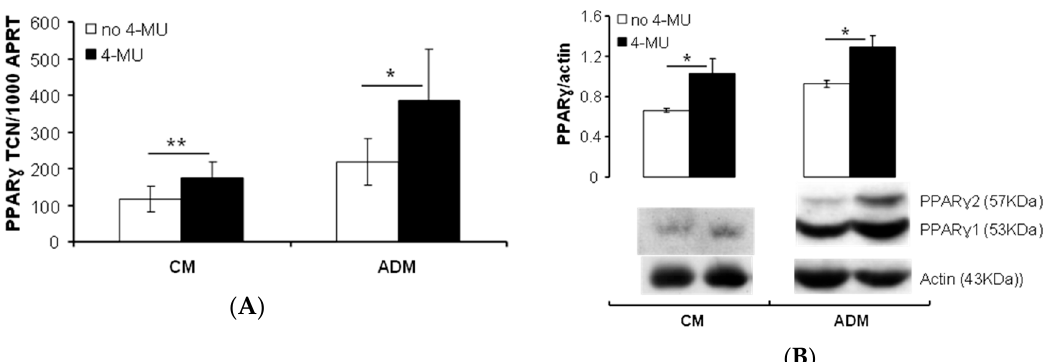
Figure 3. Enhanced PPAR γ expression by 4-MU treatment. Confluent primary subcutaneous PFs were cultured in ADM or CM with/without 4-MU for 22 days. Total RNA and nuclear protein were prepared. ( A ) PPAR γ transcripts (CM, n = 4; ADM, n = 8) and ( B ) nuclear protein ( n = 4) were analysed by QPCR and Western blotting, respectively. Results are expressed as transcript copy number (TCN) per 1000 copies of housekeeper gene (adenosine phosphoribosyl transferase (APRT)) for QPCR, or PPAR γ / actin for protein expression. Histograms = the mean ± SD ( A ) or SEM ( B ) of all samples studied. Two-tailed t-test has been used. * p < 0.04; ** p ≤